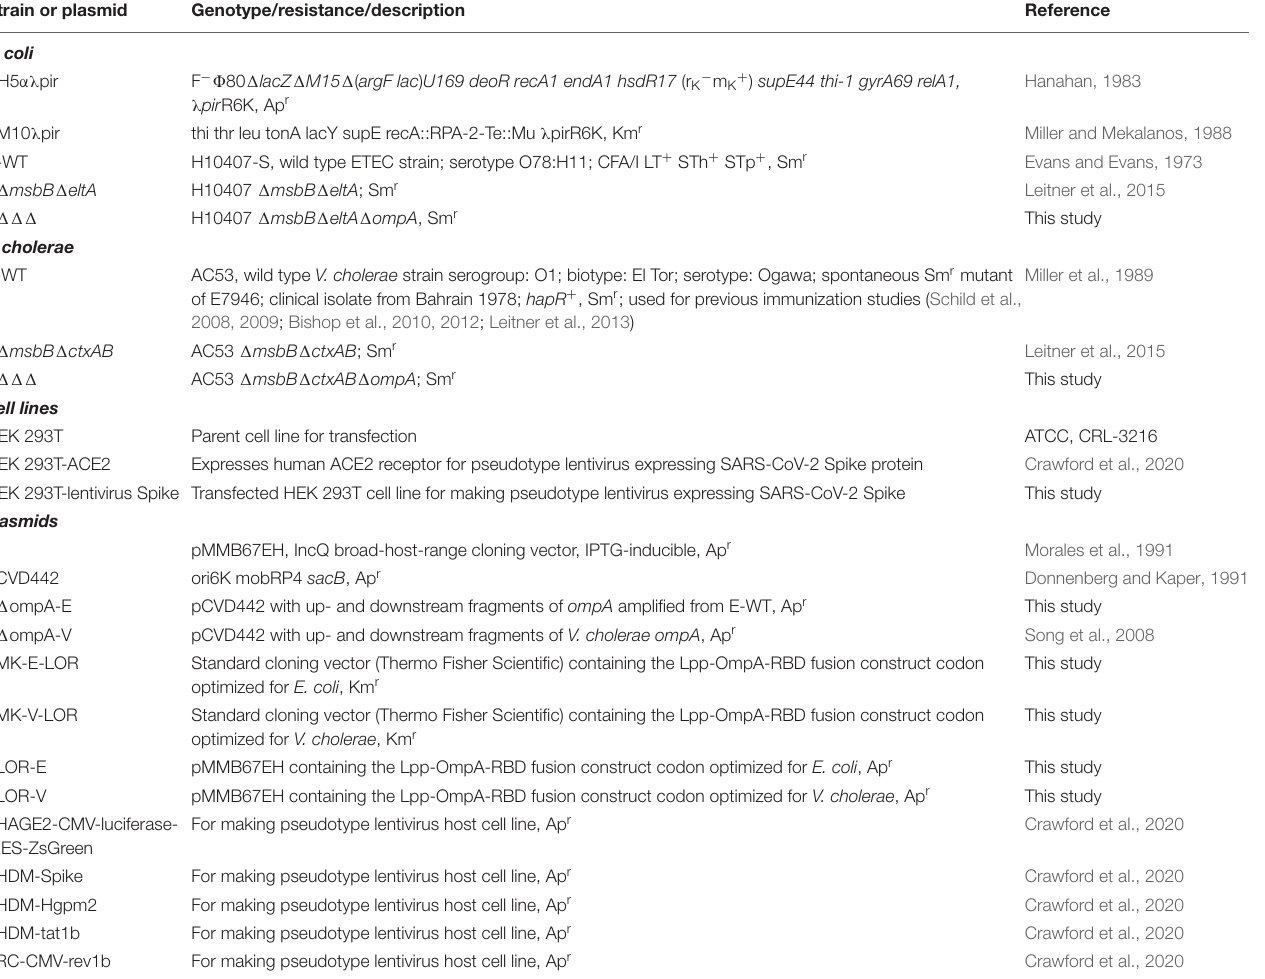
TABLE 1 | Bacterial strains, cell lines and plasmids used in this